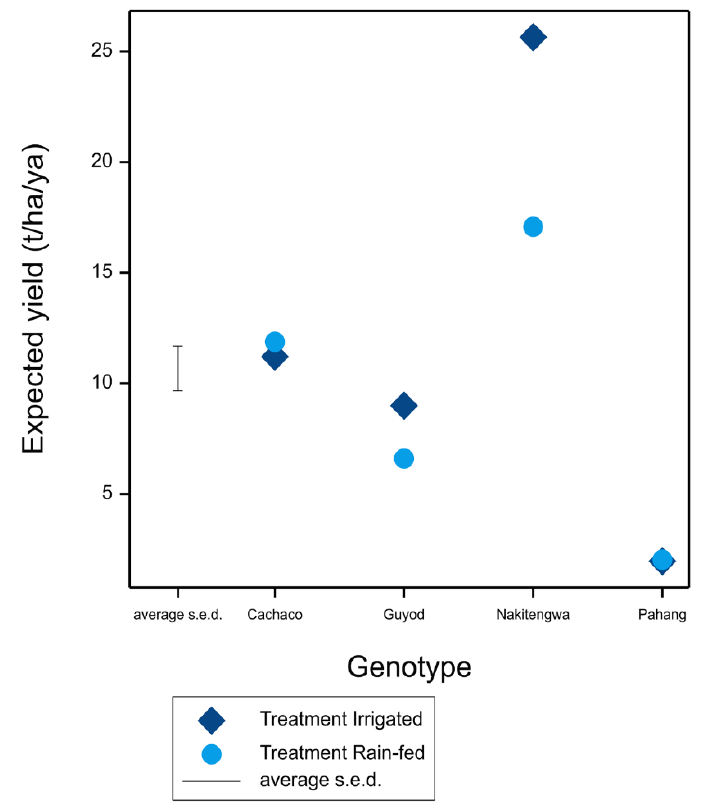
Figure 6. Means for expected yield per genotype and treatment in the first crop cycle. S.e.d.: standard error of difference.